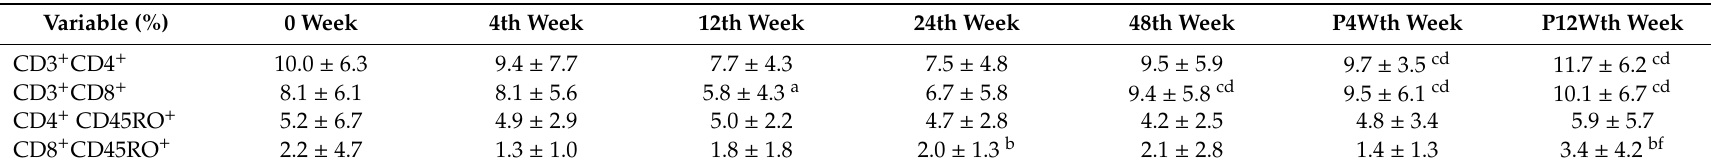
Table 4. Between CD (Cluster of di ff erentiation) marker and before and after fucoidan supplementation in chronic hepatitis B